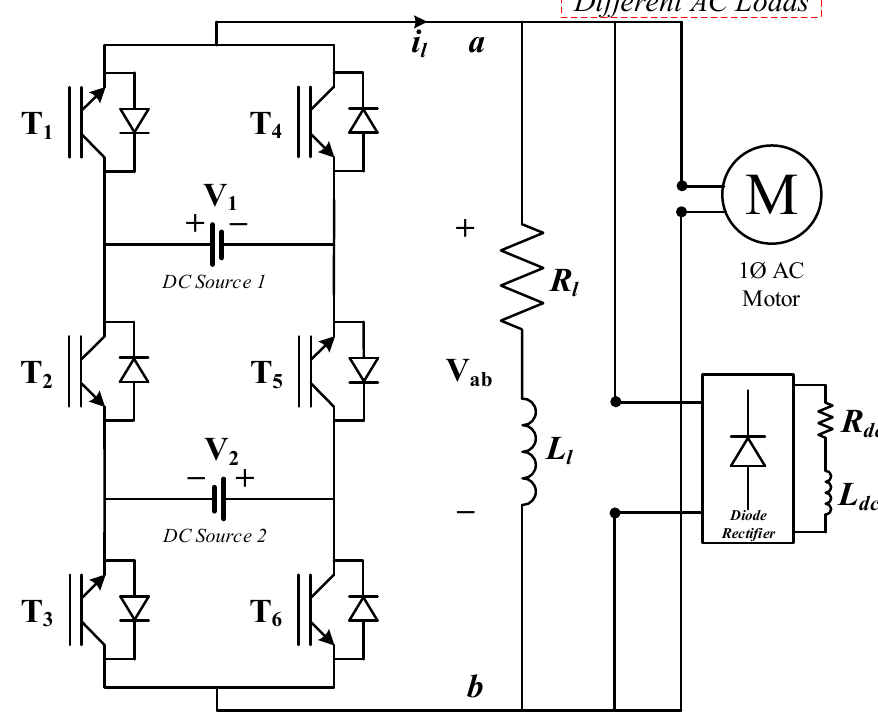
Figure 1. Single-phase seven-level MPUC inverter in standalone mode of operation.